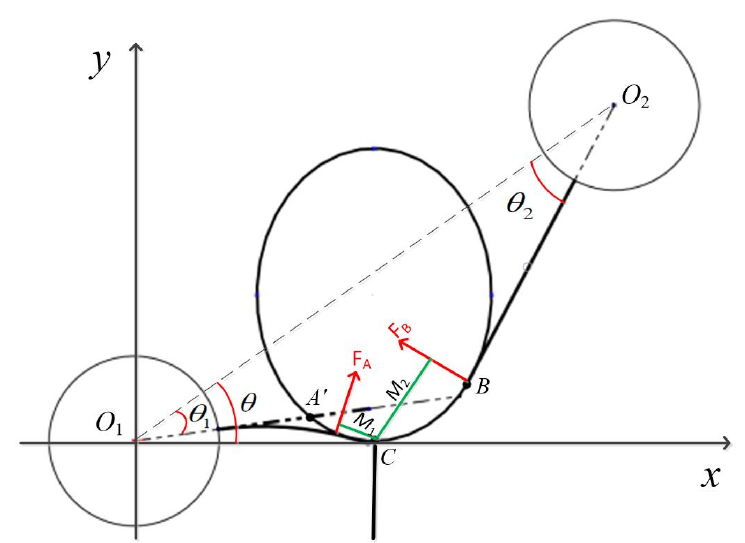
Figure 15. Force diagram of pineapple under the double flexible fingers.